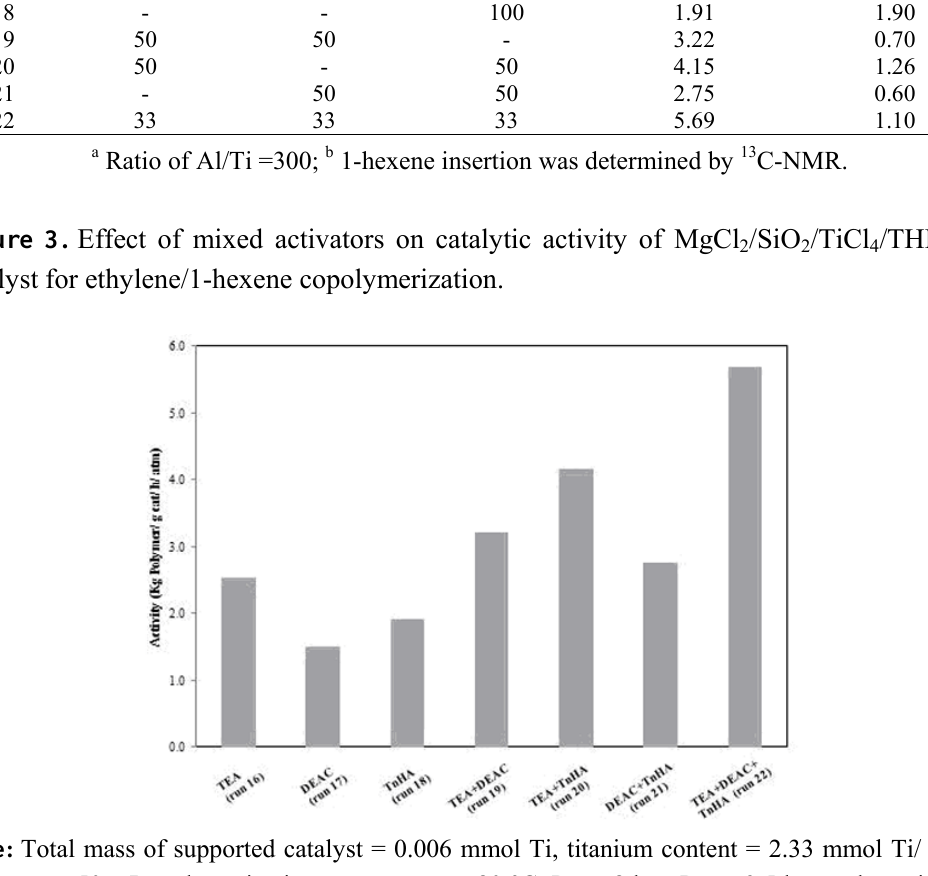
Table 2. Activity of ethylene/1-hexene copolymerization with various ratios of activators and % 1-hexene insertion.